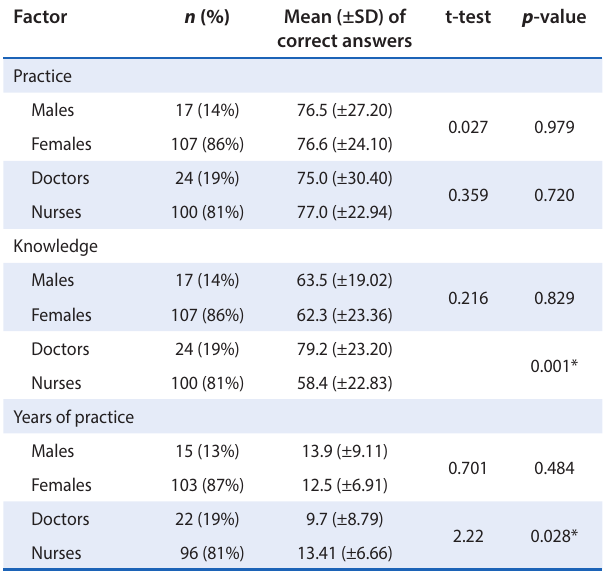
Table 3: Association between respondents’ demographic characteristics and knowledge and practice of PMTCT